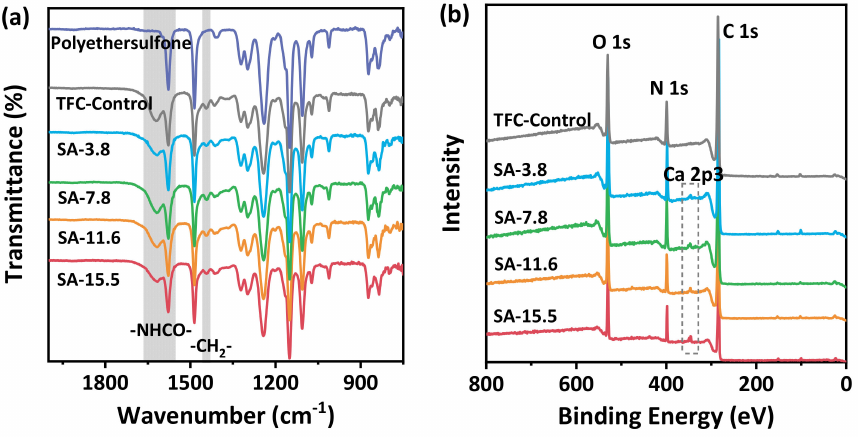
Figure 4. Chemical composition of the SA–TFC membranes: ( a ) ATR-FTIR spectra of the porous substrate, TFC − Control, and SA–TFC membranes; ( b ) XPS spectra of TFC − Control and SA–TFC membranes.